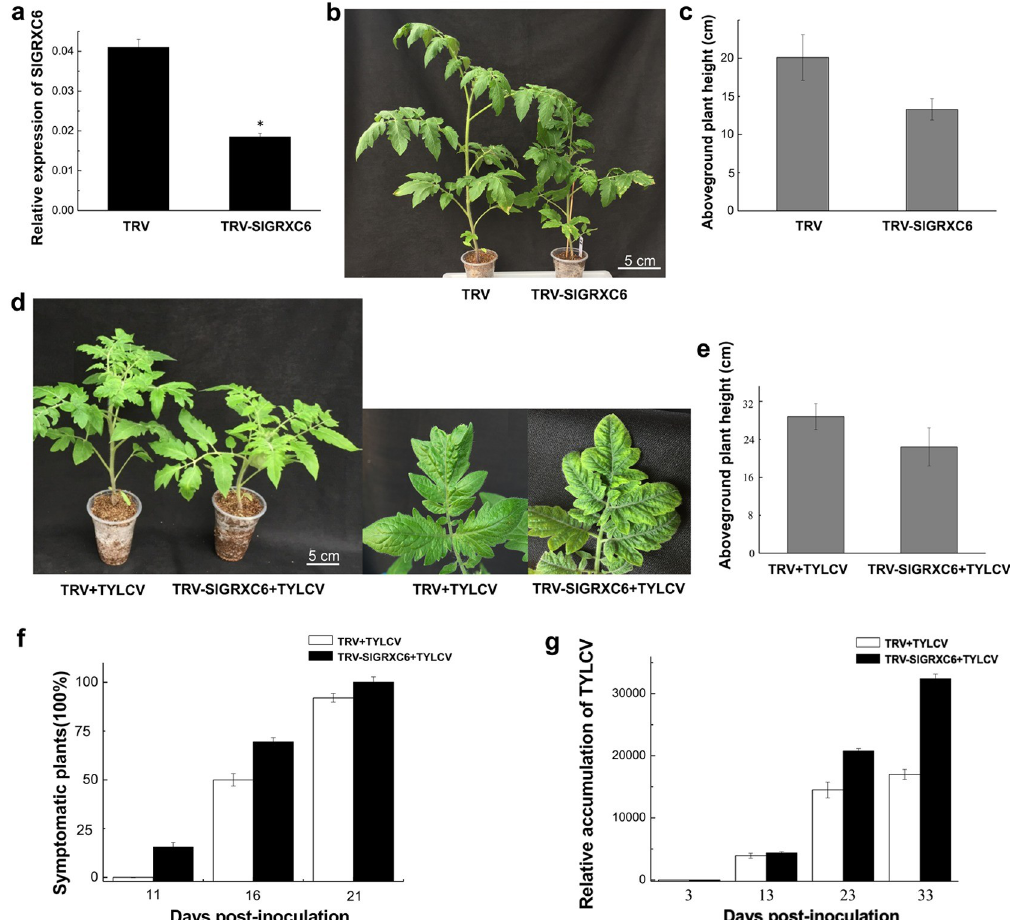
Fig 3. Knocking down the expression of SlGRXC6 promotes TYLCV infection. (a) The relative levels of SlGRXC6 transcripts in control (TRV) and knockdown (TRV-SlGRXC6) tomato plants were determined by qRT-PCR at 12 dpai with SlActin as an internal control. Data are means ± SD (n = 3). Asterisk indicates a statistically significant difference ( � p < 0.05) according to Student’s t-test. (b) Tomato plants are smaller when treated with TRV-SlGRXC6 compared to those treated with TRV. Bar: 5 cm. (c) The aboveground height of control and SlGRXC6 -silenced plants were tested at 16 dpai. (d) Symptoms caused by TYLCV in control or SlGRXC6 -silenced plants. Leaves were photographed at 13 dpi. Bar: 5 cm. (e) The aboveground height of TRV- or TRV-SlGRXC6-treated tomato plants as measured 13 days after TYLCV infection. (f) The time course of TYLCV infection in control or SlGRXC6 -silenced plants as shown in Fig 2F. Experiments were repeated three times with similar results. (g) The accumulated viral genomic DNA in systemic leaves as measured by qPCR. Accumulated levels of viral genomic DNA were tested in control or SlGRXC6 -silenced tomato plants infected with TYLCV at 3, 13, 23, and 33 dpi as shown in Fig 2A. Data are means ± SD (n = 3). Experiments were repeated three times with similar